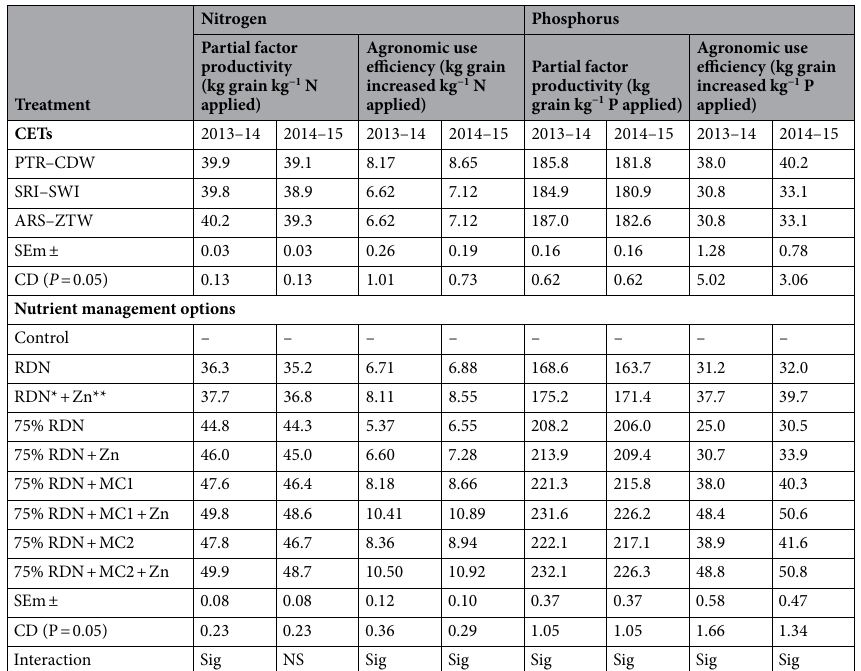
Table 10. Effect of crop establishment techniques and nutrient management options on system partial factor productivity and agronomic use efficiency for nitrogen and phosphorus during 2013–2014 and 2014–2015. PTR , Puddled transplanted rice; SRI , System of rice intensification; ARS , Aerobic rice system; CDW , Conventional drill-sown wheat; SWI , System of wheat intensification; ZTW , Zero tillage wheat; RDN*